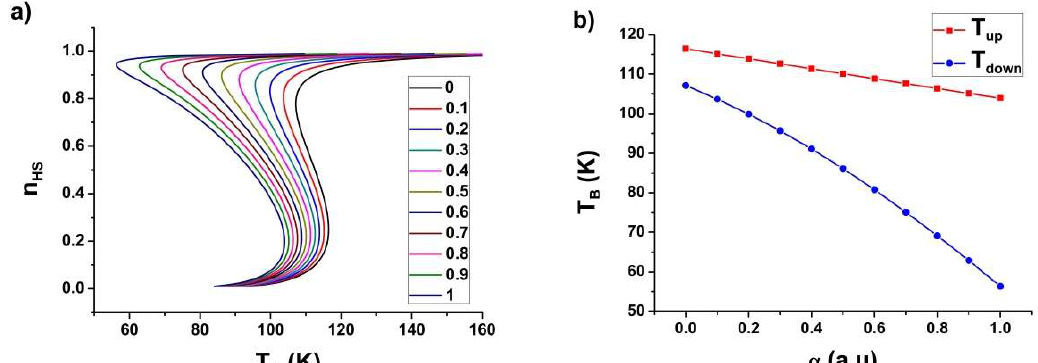
Figure 8. ( a ) Simulated bath-temperature ( T B ) dependence of the HS fraction under light causing its photo-heating for various light intensity values, given in arbitrary units. ( b ) Light intensity dependence of the upper and lower transition temperatures of the thermal hysteresis. Parameter values are: J = 155 K, ∆ = 394 K, g = 1097, C LS p = 0.1 a.u., and C HS p = 0.01 a.u. (arbitrary units).